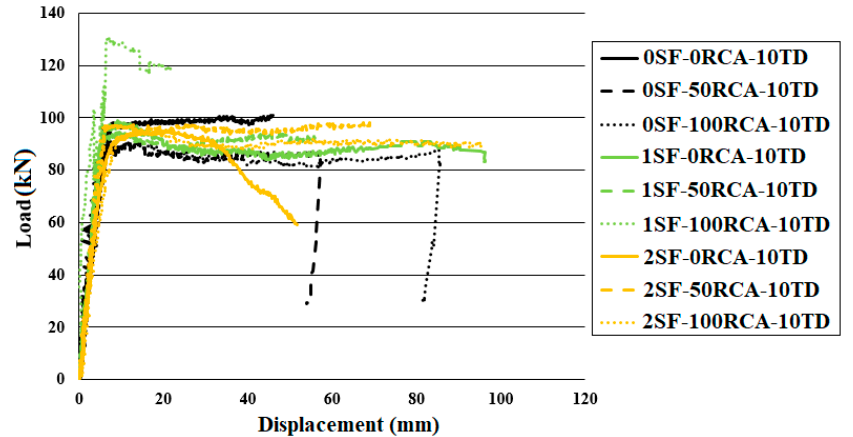
Figure 18. Bending behaviour of specimens with various S values and RCA contents and a 100 mm shear rebar spacing.